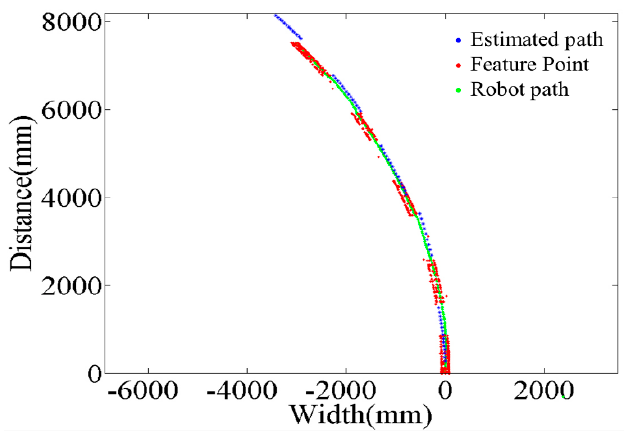
Figure 18. Predicted path for driving.